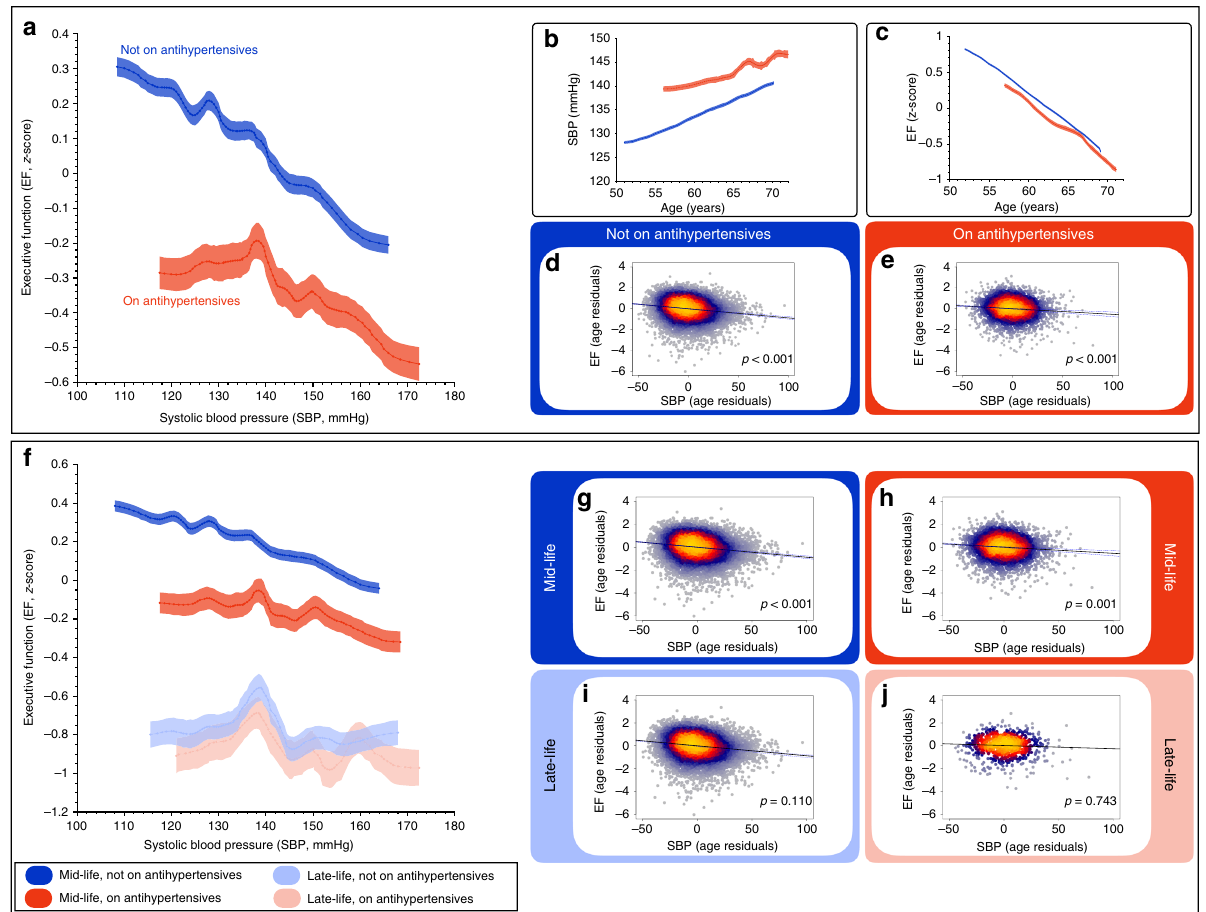
Fig. 2 Relationship between blood pressure and executive function. a Higher systolic blood pressure (SBP) was associated with lower executive function (EF) for both participants who were on antihypertensives and those who were not. For those on antihypertensives, there was a non-linear relationship as EF was not associated with a decline for SBP measurements<140mmHg (EF standardised into z -score, a – c , f : shaded area represents standard error around the mean. b , c SBP increased with age, while EF declines with age, respectively, for participants who take antihypertensives and those who do not. d , e Association between EF and SBP using age residuals (adjusting for age) for participants who were not on antihypertensive medication (Pearson correlation, r = – 0.155, 95% CI [ − 0.172, − 0.139], p <0.001, n = 16,410) and participants who are ( r = − 0.093, 95% CI [ − 0.126, − 0.060], p <0.001, n = 4699) with the difference between correlation coef fi cients being signi fi cant following Fisher ’ s r to z transformation, z = − 3.84, p <0.001). f When considering age groups, higher SBP was associated with lower EF in mid-life (44 – 69 years) participants but not in the late-life (70 – 73 years) group (shaded area represents standard error). g , h Age- adjusted analysis between SBP and EF for participants not on an antihypertensives ( r = − 0.134, 95% CI [ − 0.152, − 0.115], p <0.001, n = 13,242) and those who were on antihypertensives ( r = − 0.062, 95% CI [ − 0.100, − 0.024], p = 0.001, n = 3071), within the mid-life group (difference between group correlation coef fi cients, z = − 3.62, p <0.001). I , j Same relationship in the late-life group showing no signi fi cant correlation between SBP and executive function regardless of whether they were on antihypertensive medication ( r = − 0.056, 95% CI [ − 0.1247, 0.0129], p = 0.110, n = 1869 and r = 0.008, 95% CI [ − 0.0416, 0.0582], p = 0.743, n = 949). SBP systolic blood pressure; EF executive function; CI con fi dence